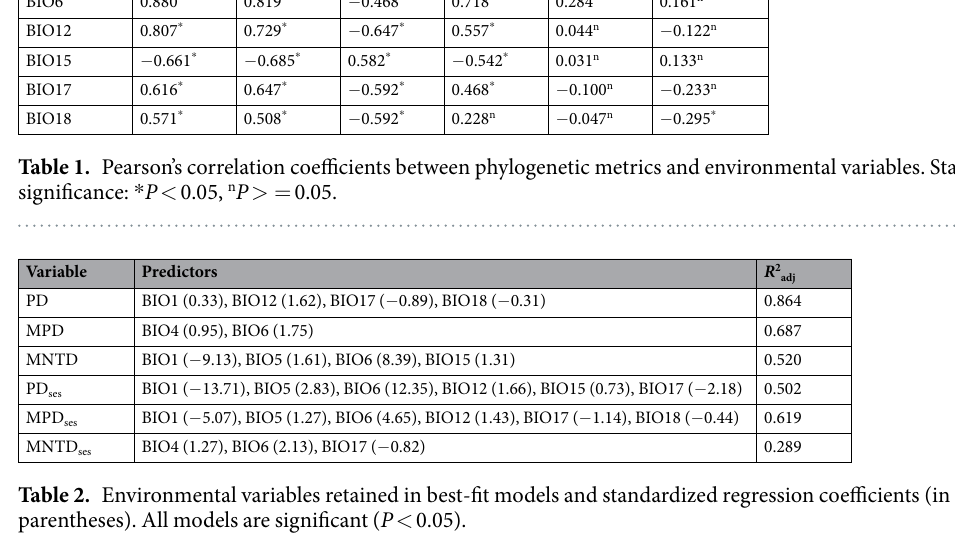
Table 2. Environmental variables retained in best-fit models and standardized regression coefficients (in parentheses). All models are significant ( P <